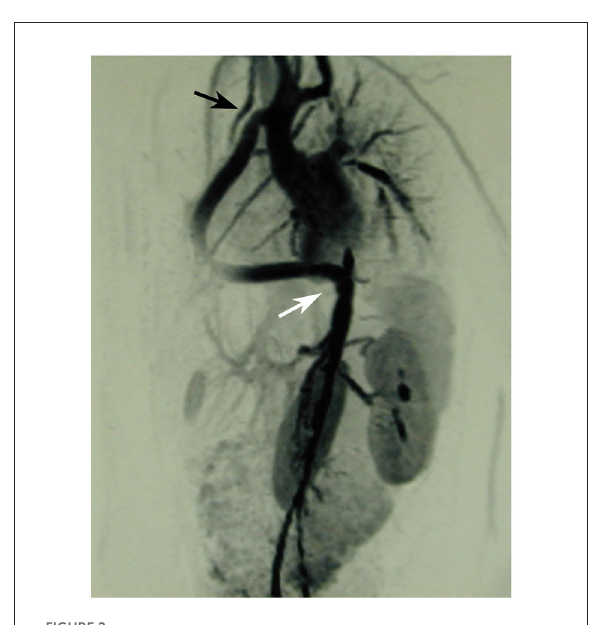
FIGURE2 The ascenders-supraceliac bypass is implanted on the right side of the ascending aorta, then in front of the inferior vena cava and exits the pericardial cavity through a limited incision in the posterior pericardium and in the diaphragm to be anastomosed with the supra celiac aorta. Reproduced with permission from ICVTS 2003;